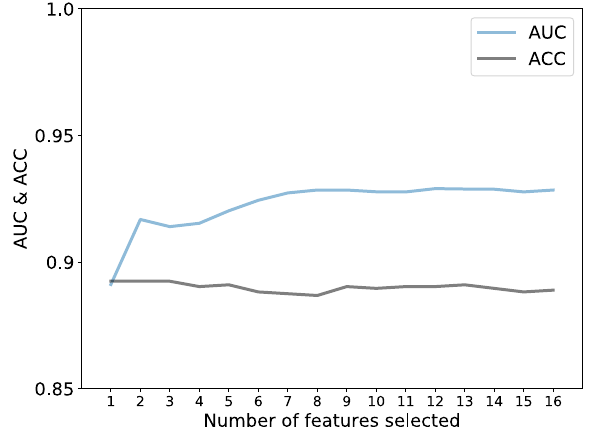
FIG. 4. The AUC and ACC for each number of features selected. The features are ordered the same as Fig. 3.